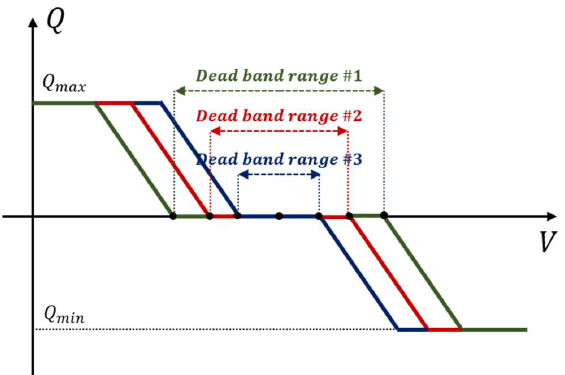
Figure 5. Various dead band setting.